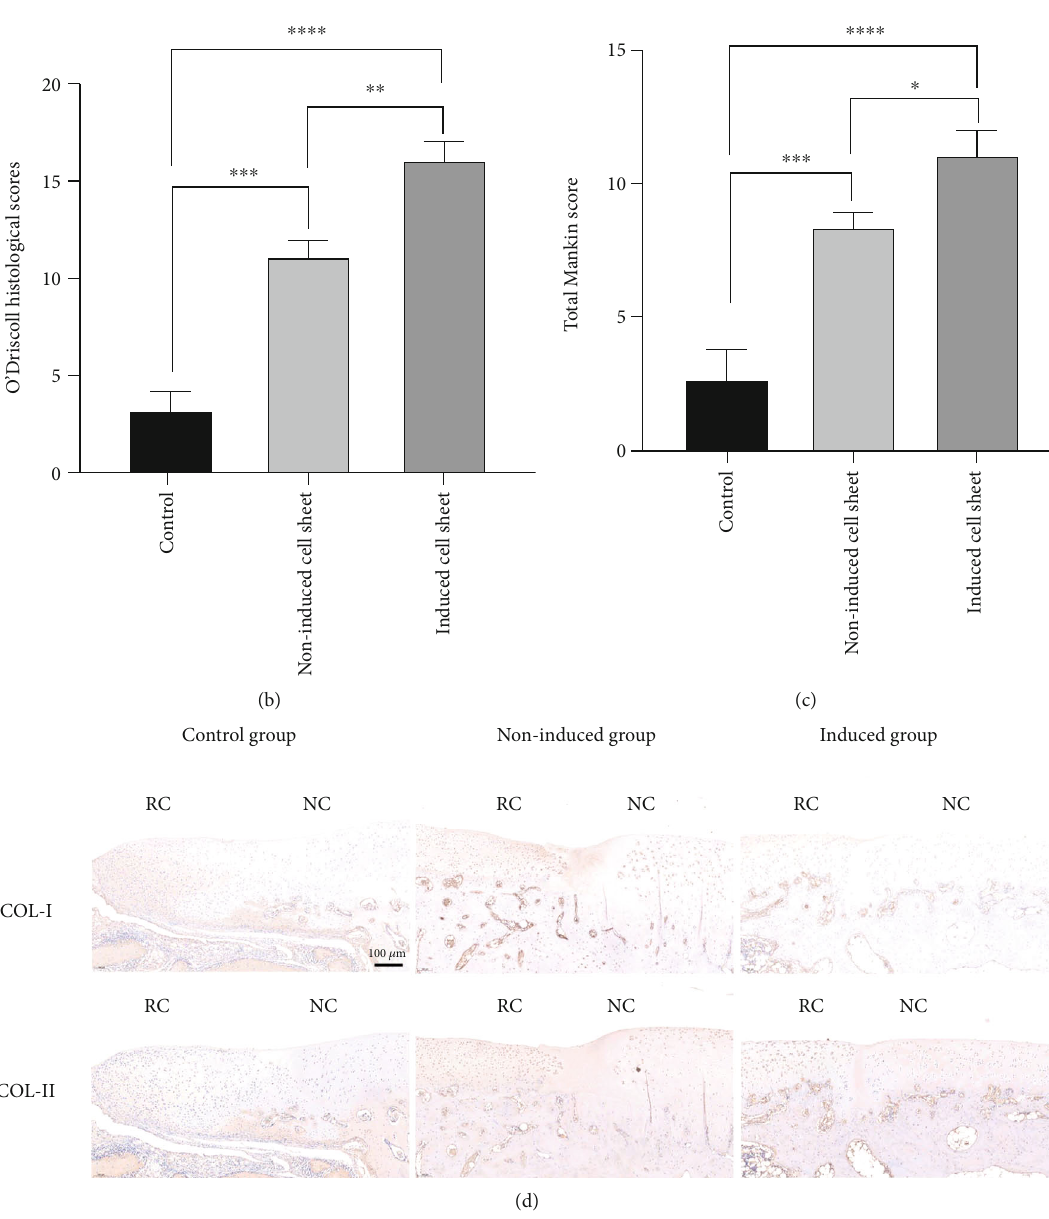
Figure 7: (a) Histological examination of regenerated tissue in all groups at 12 weeks postoperatively. TB: toluidine blue; SO/FG: Safranin- O/Fast-green. Scale bar: 1 mm and 500 μ m. (b) O ’ Driscoll histological scores of groups at 12 weeks postoperatively, ∗∗ P < : 01 , ∗∗∗ P < : 001 , ∗∗∗∗ P < : 0001 . (c) The Mankin scores of groups at 12 weeks postoperatively, ∗ P < : 05 , ∗∗∗ P < : 001 , ∗∗∗∗ P < : 0001 . (d) Immunohistochemical staining of COL-I and COL-II. Scale bar: 100 μ m. RC: regenerated cartilage; NC: normal